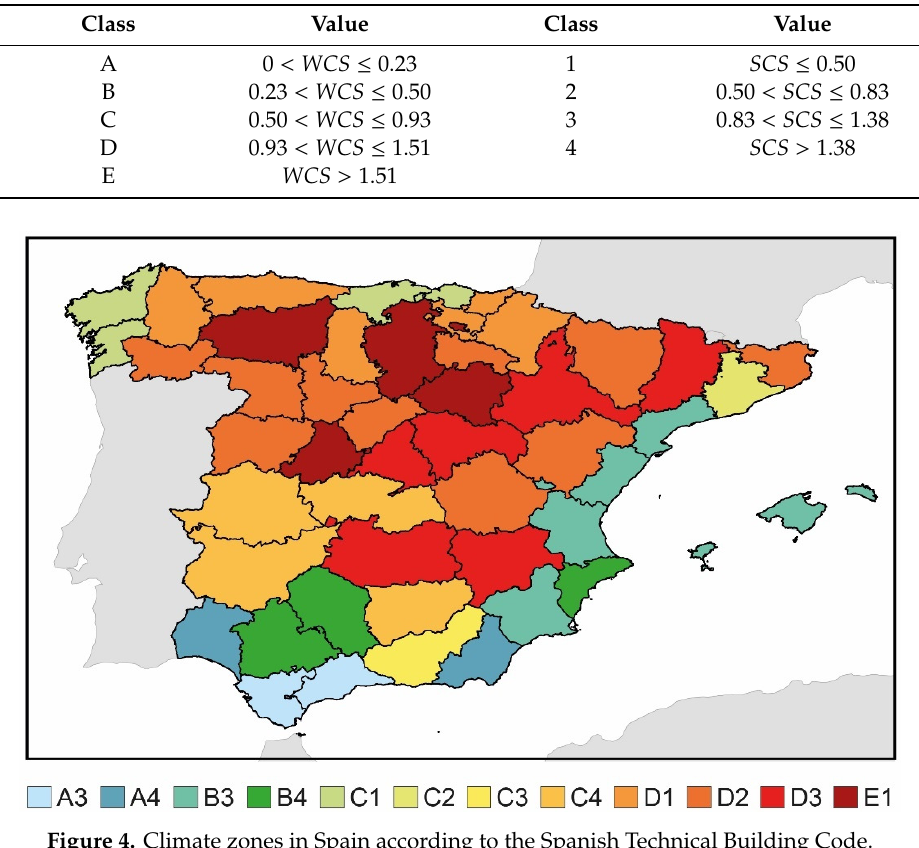
Figure 4. Climate zones in Spain according to the Spanish Technical Building Code.